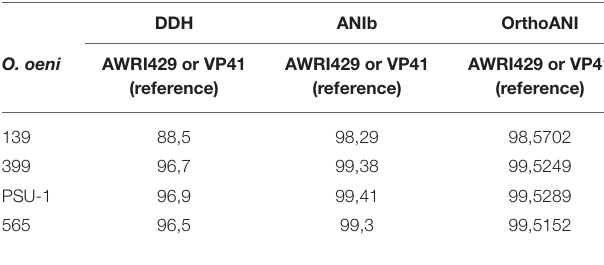
TABLE 4 | Occurrence of esterases, glycosidases, citrate metabolism, peptidases, and proteases enzymes of autochthonous O. oeni genomes compared with reference strains (VP41 and